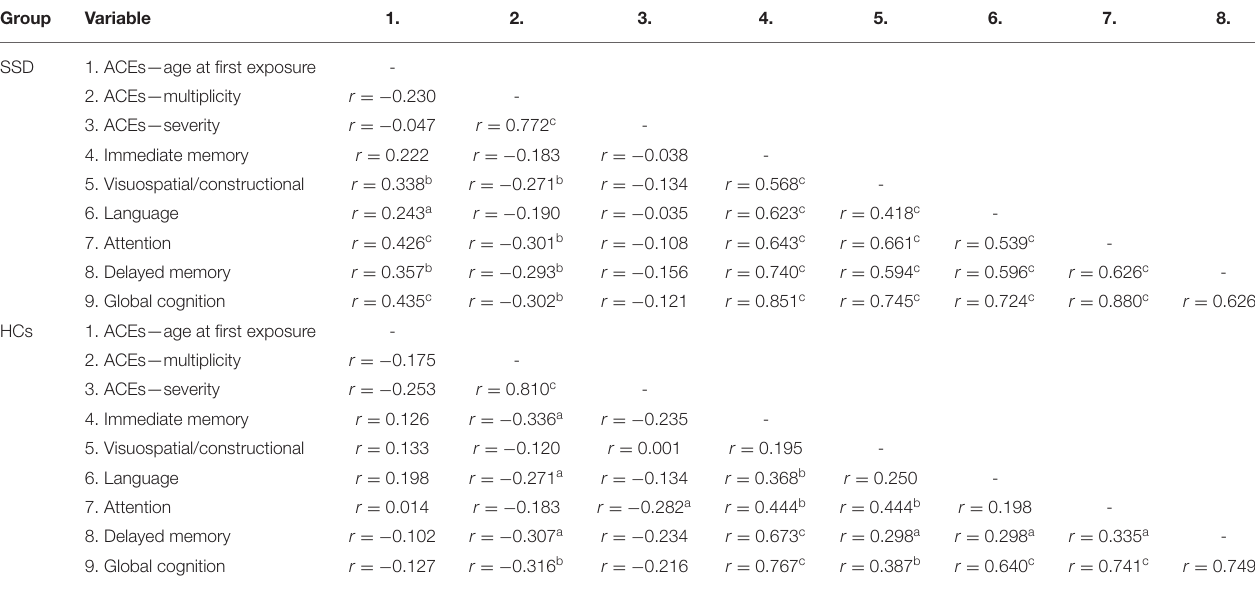
TABLE 2 | Bivariate correlations between the measures of ACEs and cognitive performance scores. Group